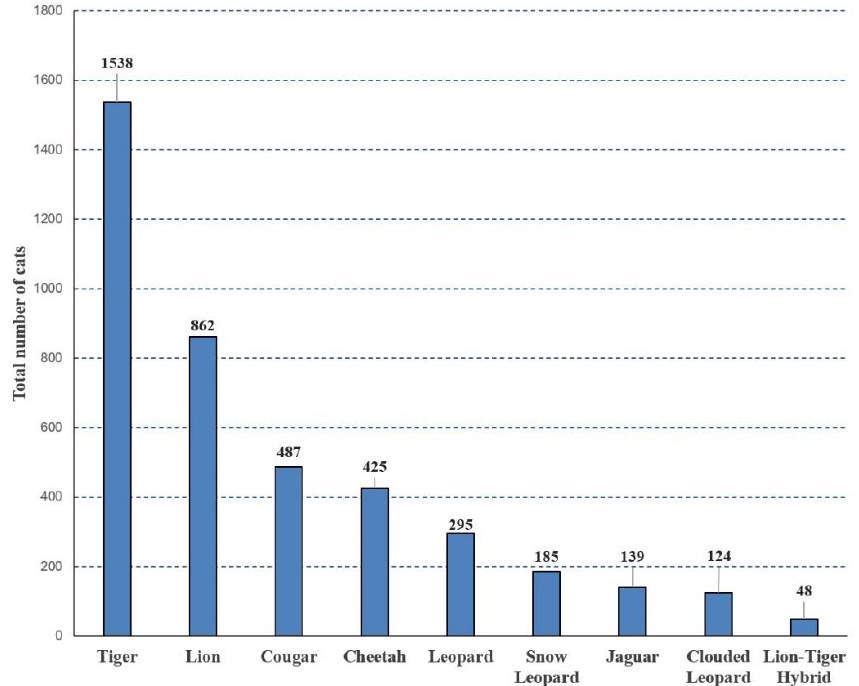
Figure 2. Federally regulated facilities holding big cat species sorted by accreditation. Note: Both the AZA and the ZAA accredit a small number of non-zoo facilities.